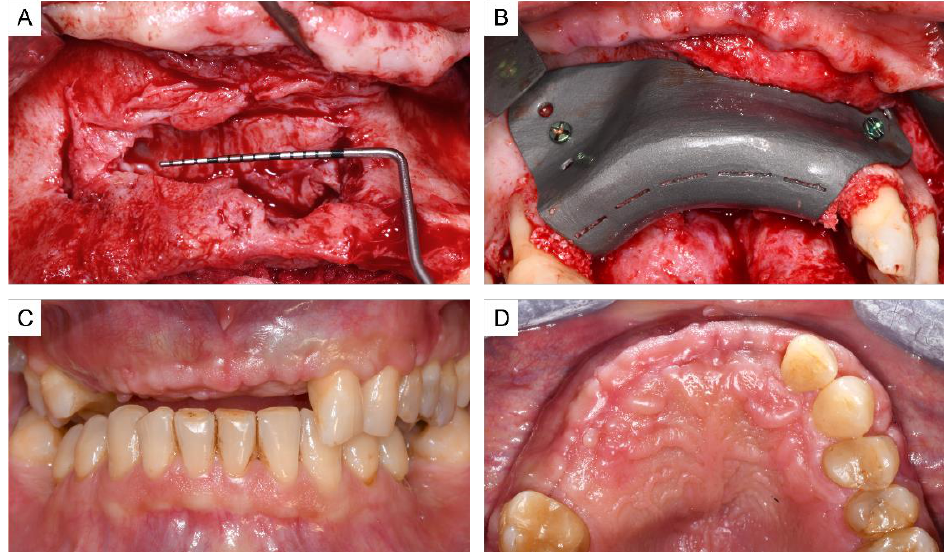
Figure 7. The intra-operatory clinical vision of the defect ( A ), the membrane fixed ( B ) and clinical situation a month after surgery ( C , D ). A new cone-beam CT was taken to verify the bone augmentation and the mesh po- sition after one month of healing, showing a good healing process without the mem- brane shifting (Figures 8 and 9).